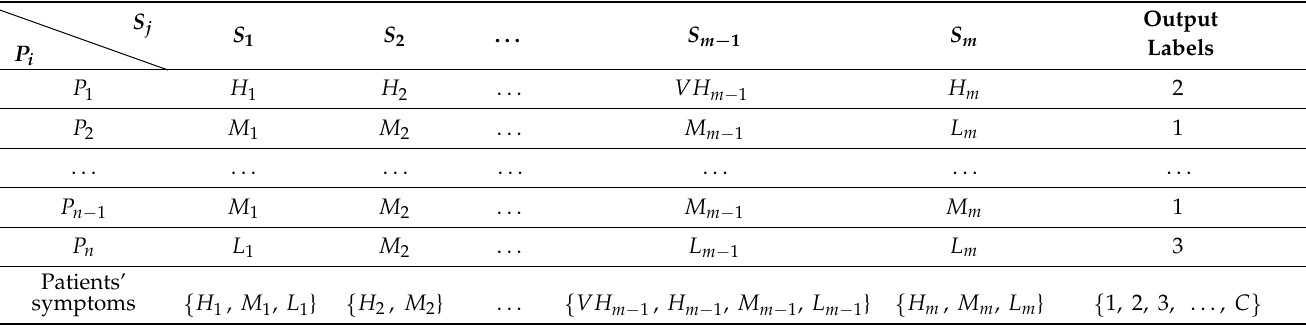
Table 1. The fuzzy rule